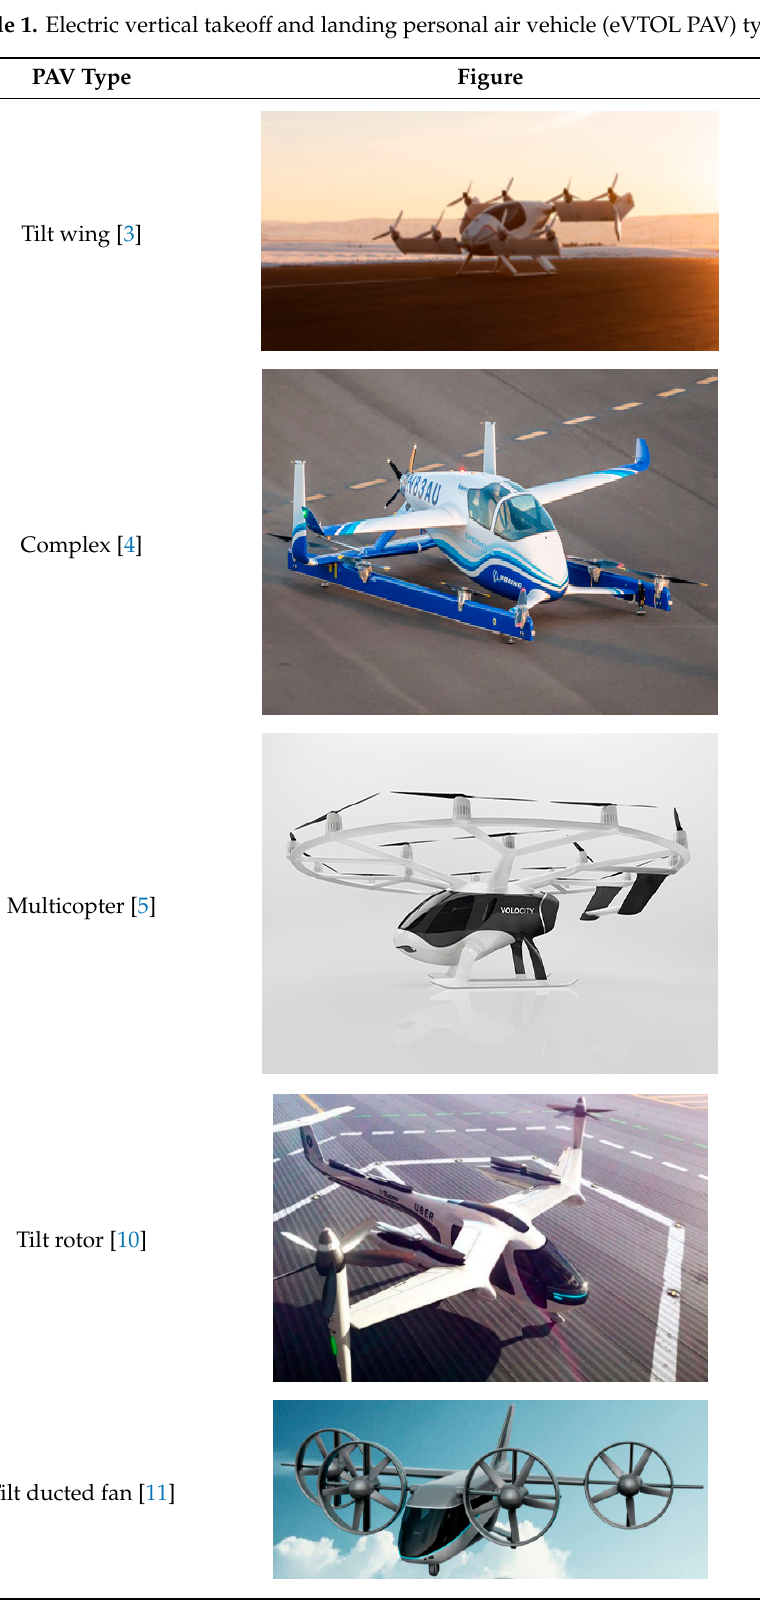
Table 1. Electric vertical takeoff and landing personal air vehicle (eVTOL PAV) type.